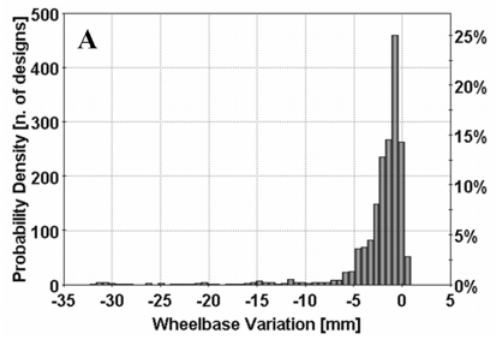
pitch angle tend to be more pronounced.